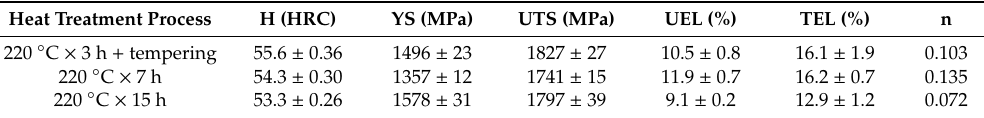
Table 2. The mechanical properties of the experimental steels underwent di ff erent heat treatment processes. (UEL: uniform elongation, TEL: total elongation, n: strain hardening exponent, YS: yield strength, UTS: ultimate tensile strength) .